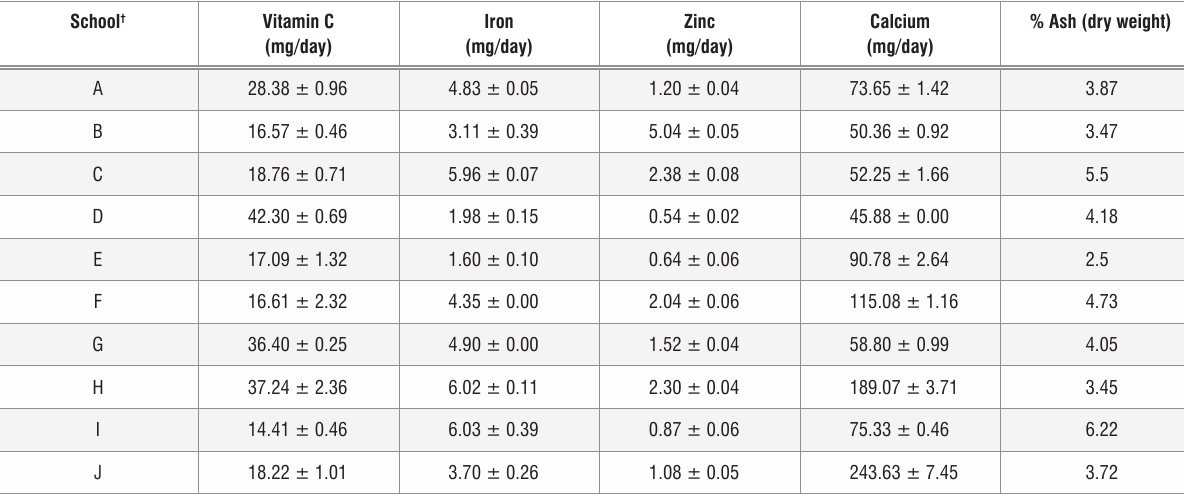
Micronutrient content of meals sampled from various